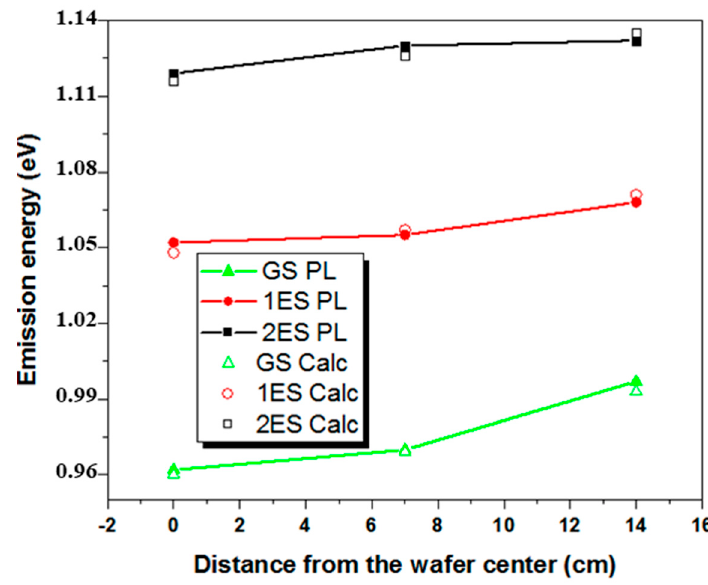
Figure 7. Experimental and calculated emission energies from the QDs’ Ground states (GS) (black squares) and first (1ES) (red circles) and second excited states (2ES) (green triangles) used to determine the mean dots size and shape: lines and full symbols are experimental PL data while empty symbols show the numerical values. The error made on the determination of the peak position is estimated to be less than 1%.